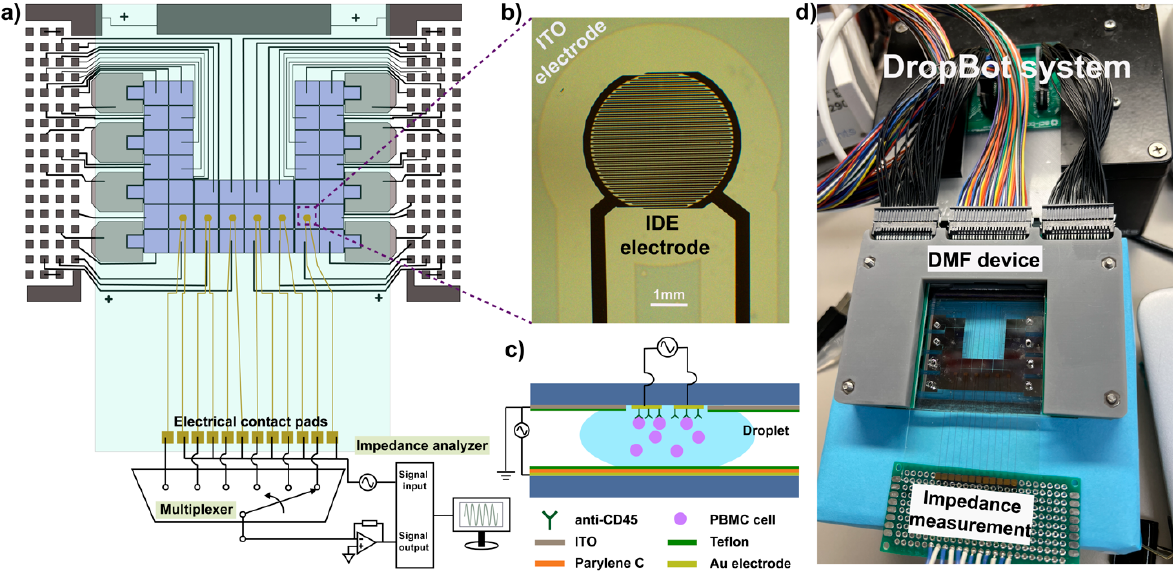
Figure 1. ( a ) Overview of DMF device with integrated interdigitated electrodes (IDEs). Schematic illustration of the device showing 40 actuation electrodes on the bottom plate and 6 sets of sensing electrodes on the top plate. The sensing electrodes were connected to a multiplexer and an impedance analyzer for the detection; ( b ) Microscopic image of IDE electrodes deposited on the top plate. ( c ) Cross-section diagram of the device, with a droplet of cells on the sensing electrodes (not to scale); ( d ) A photo demonstrating the assembly of an integrated DMF device. DropBot system was used to operate the device; the impedance measurement was conducted by connecting electrical contact pads to a digital impedance analyzer.